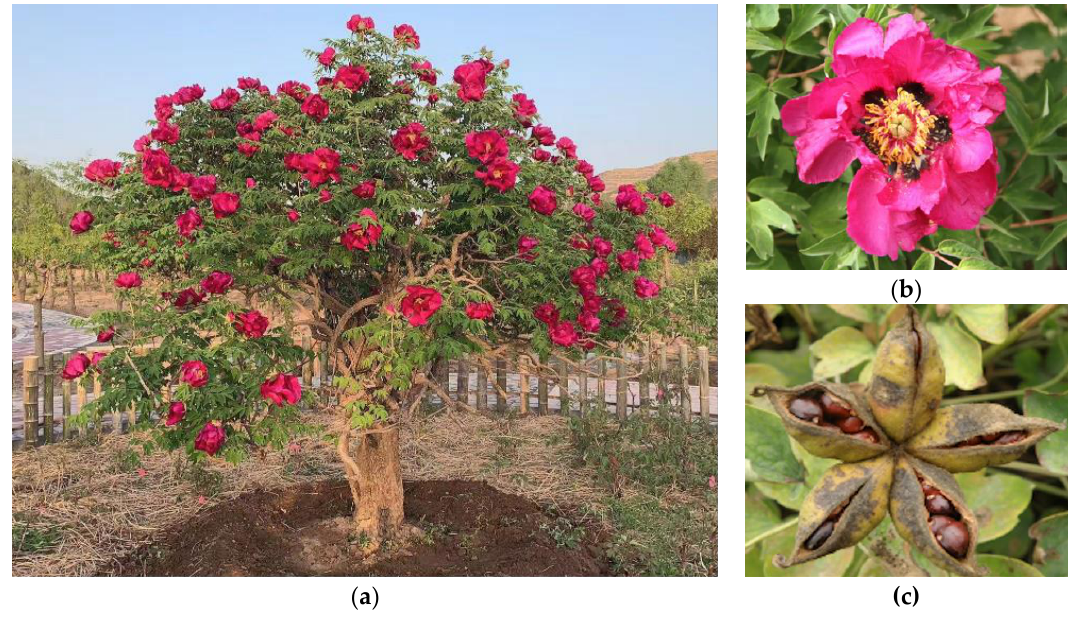
Figure 1. The morphological characteristics of P. rockii plant: ( a ) P. rockii has more fragrant blossoms, and taller and stronger plants with more longevity, ( b ) there is a colored flare at the base of petals, and ( c ) with strong fertility, the ripe follicles contain a large number of seeds.